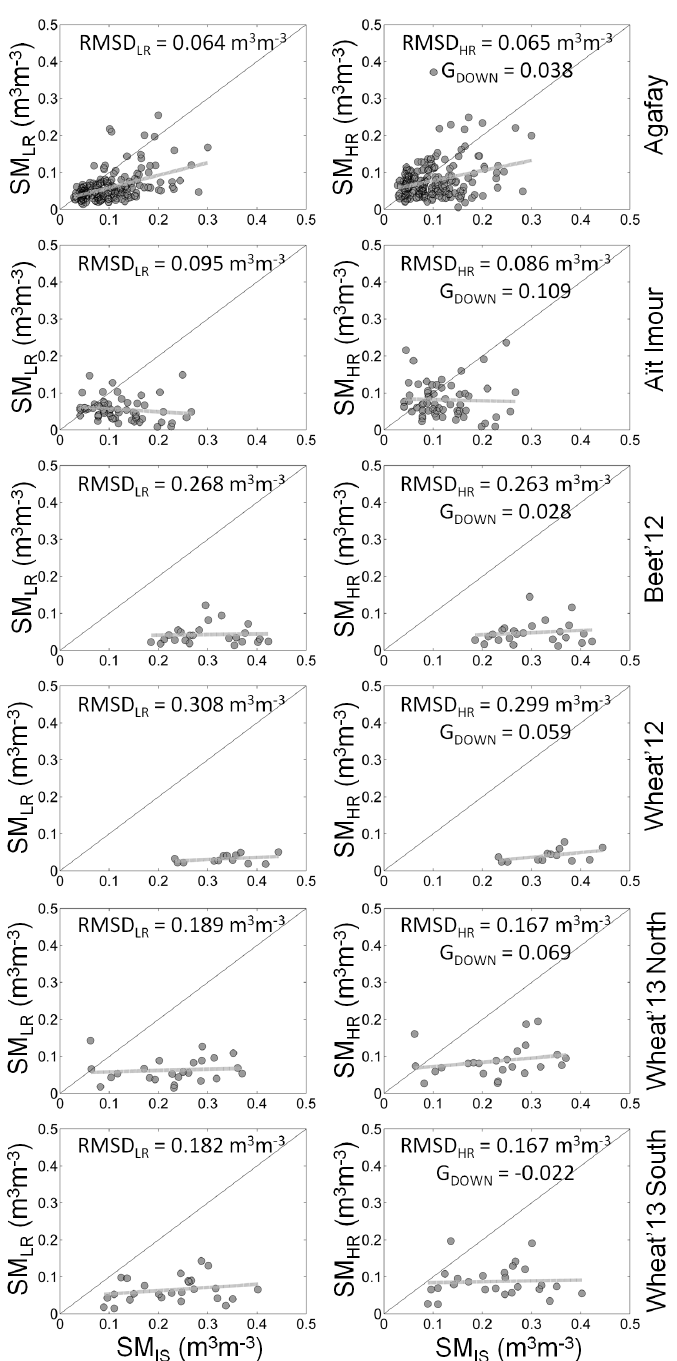
Figure 5. LR (left) and HR disaggregated (right) soil moisture vs. in situ measurements for each site separately (whole time series) and for a DISPATCH count threshold set to three (SMOS ascending (A)